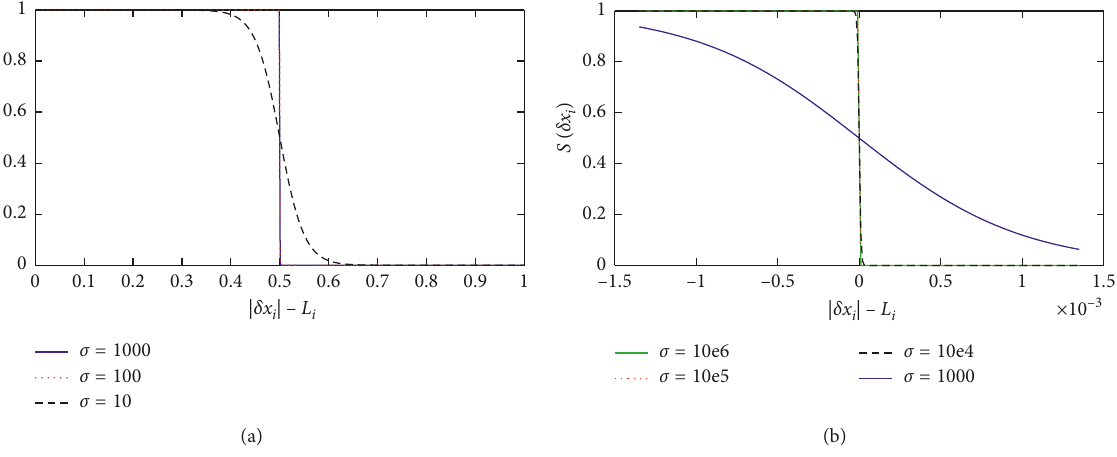
Figure 6: Approximating effects for various values of σ .